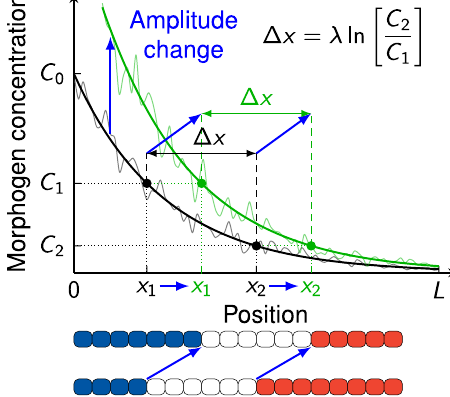
Fig. 9 Robustness of patterning domain sizes to amplitude changes in the French fl ag model. The domain length Δ x = x 2 − x 1 is independent of the amplitude C 0 of an exponential gradient. Amplitude changes therefore shift interior domain boundaries